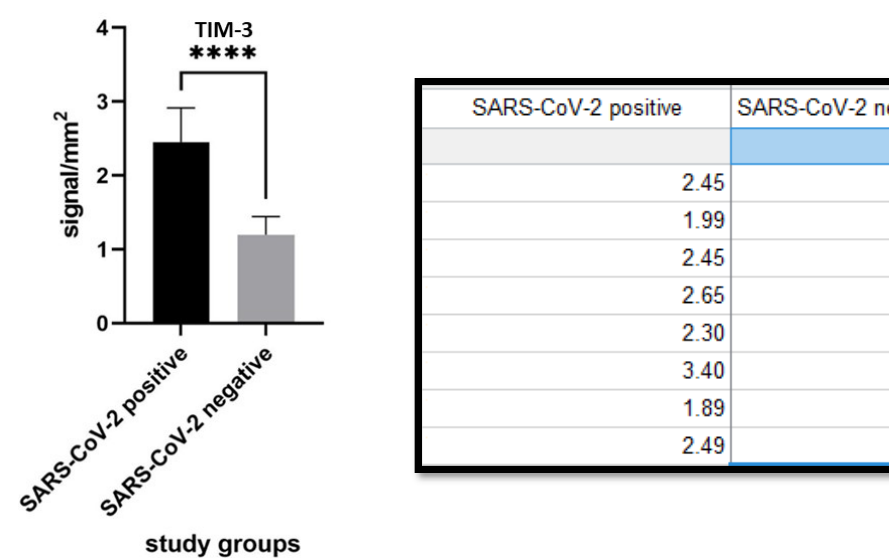
Figure 8. ( A ) Immunostaining for HO-1: note the positivity of a few inflammatory cells available mainly subepithelial in the skin of a patient positive for SARS-CoV-2 (Immunohistochemistry, Original Magnification: 40×). The light brown color